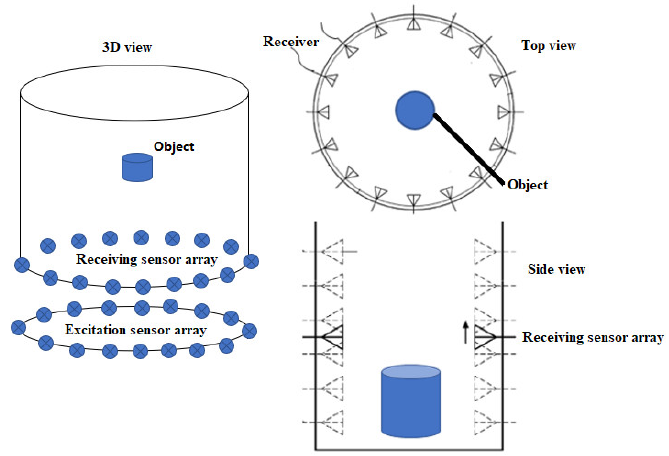
Figure 1. Schematic of the 3D HEI system.